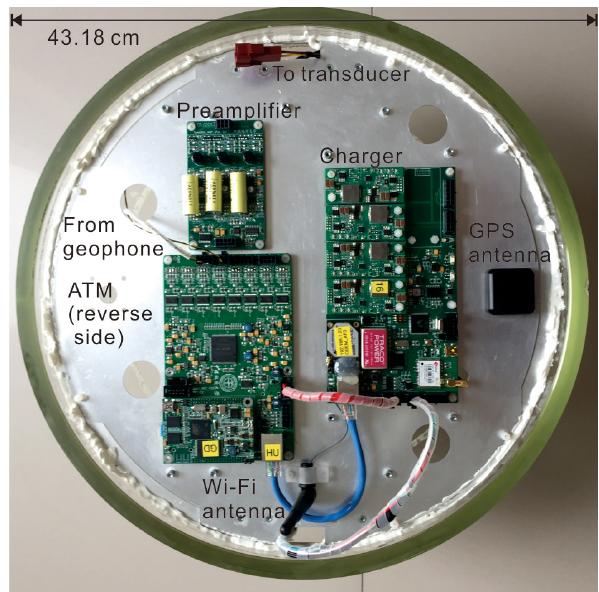
Figure 4. Photo of the data logger installed in the glass sphere. Un- der the aluminum board, an ATM, Li-ion rechargeable battery set, and three-axis geophone are fixed. After circuit assembly, magnetic shielding covers the three print circuit boards to decrease sensor